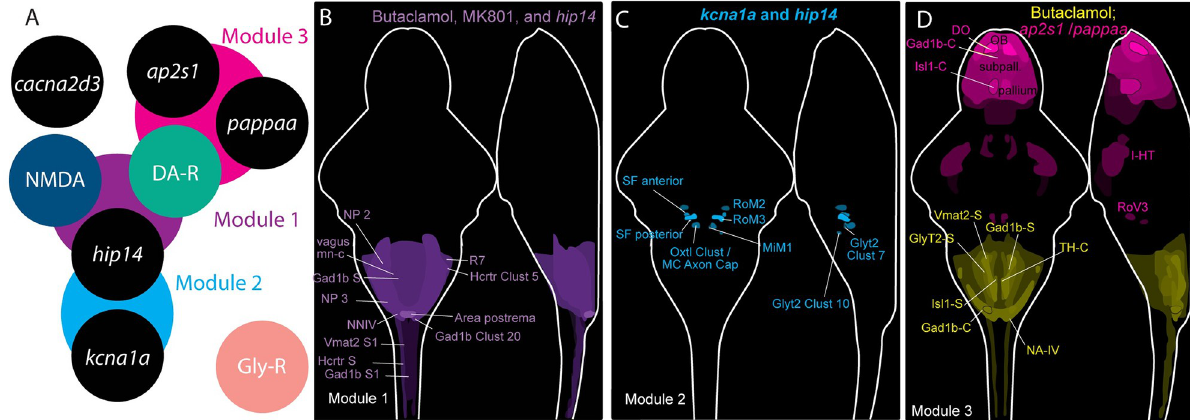
Fig 8. Cluster analysis proposes candidate habituation regulatory modules. (A) Module 1 (purple) comprises hip14 , NMDA, and dopamine receptors. Module 2 (aqua) comprises hip14 and kcna1a . Module 3 (pink) comprises ap2s1 , pappaa , and dopamine receptors. Modules 4 and 5 are comprised of cacna2d3 and glycine receptor signaling acting in parallel to all other modules. (B) Regions commonly upregulated by dopamine inhibition, NMDA inhibition, and mutations in hip14 are indicated in purple. (C) Regions upregulated by mutations in kcna1a and hip14 are indicated in blue. (D) Regions downregulated by dopamine receptor inhibition and upregulated by mutations in ap2s1 or pappaa are indicated in pink. Regions upregulated by dopamine receptor inhibition and downregulated by mutations in pappaa or ap2s1 are indicated in yellow. See also S3 Fig for cluster analysis heat map and correlations between pharmacogenetic treatments. In (B-D) , signal intensity is proportional to the sum of the absolute intensity values. Abbreviations in (B) : NP2 = Rhombencephalon–Neuropil Region 2, X vagus mn cluster = Rhombencephalon—X Vagus motorneuron cluster, Gad1b S = Rhombencephalon Gad1b Stripe 2, NP3 = Rhombencephalon Neuropil Region 3, NNIV = Rhombencephalon—Noradrendergic neurons of the Interfascicular and Vagal areas, Vmat2 S1 = Spinal Cord—Vmat2 Stripe1, Hcrtr S = Spinal Cord—6.7FDhcrtR-Gal4 Stripe, Gad1b S1 = Spinal Cord —Gad1b Stripe 1, R7 = Rhombomere 7, Hcrtr Clust 5 = Rhombencephalon—6.7FDhcrtR-Gal4 Cluster 5, Area postrema = Rhombencephalon Area Postrema, Gad1b Clust 20 = Rhombencephalon—Gad1b Cluster 20. Abbreviations in (C) : SF anterior = Rhombencephalon—Spiral Fiber Neuron Anterior cluster, SF posterior = Rhombencephalon—Spiral Fiber Neuron Posterior cluster, Oxtl Clust MC Axon Cap = Rhombencephalon—Oxtl Cluster 2 Near MC axon cap, RoM2 = Rhombencephalon—RoM2, RoM3 = Rhombencephalon–RoM3, MiM1 = Rhombencephalon—MiM1. Abbreviations in (D) : DO = Telencephalon—Olfactory bulb dopaminergic neuron areas, Gad1b-C = Telencephalon—Subpallial Gad1b cluster, Isl1-C = Telencephalon—Isl1 clusters 1 and 2, OB = Telencephalon—Olfactory Bulb, Subpall = Telencephalon–Subpallium, Pallium = Telencephalon– Pallium, Vmat2-S = Rhombencephalon—Vmat2 Stripe2, GlyT2-S = Rhombencephalon—Glyt2 Stripe 2, Isl1b-S = Rhombencephalon Isl1 Stripe1, Gad1b-C = Rhombencephalon—Gad1b Cluster 20, Gad1b-S = Rhombencephalon—Gad1b Stripe 2, TH-C = Rhombencephalon—Small cluster of TH stained